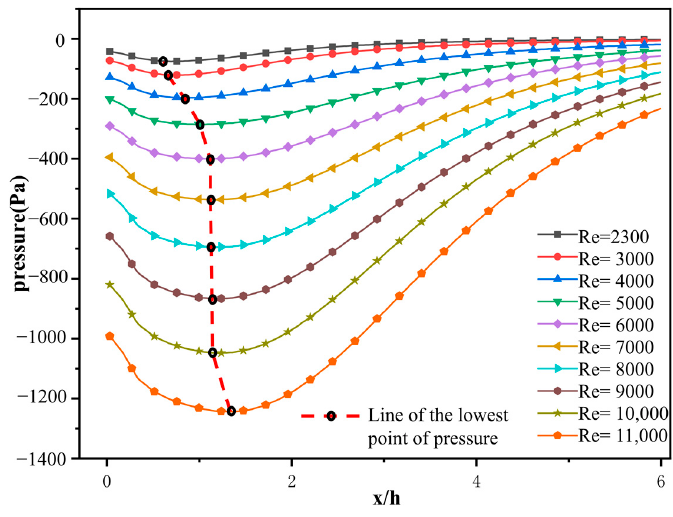
Figure 14. Pressure distribution at different Reynolds numbers.